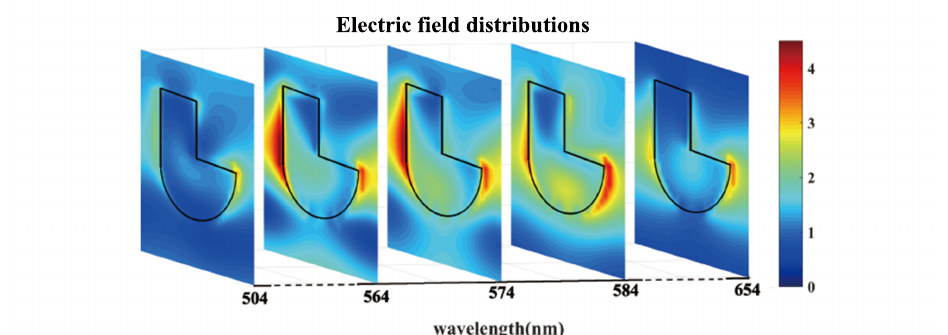
Figure 4. The electric field (E-field) distributions of the a-Si hook shaped nanostructure in the x-y plane when electric dipole (ED) and magnetic dipole (MD) resonances are overlapped at wavelength of 504 nm, 564 nm, 574 nm, 584 nm and 654 nm.